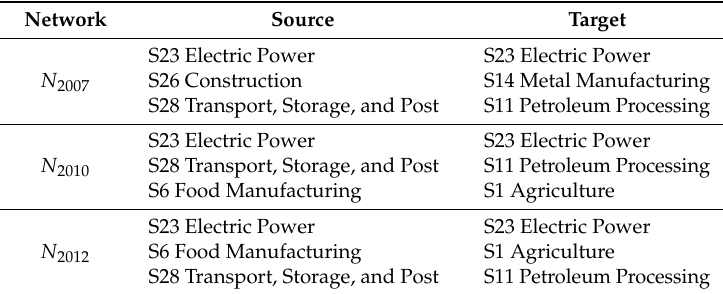
Table 6. Edges with the top three weights in each network.